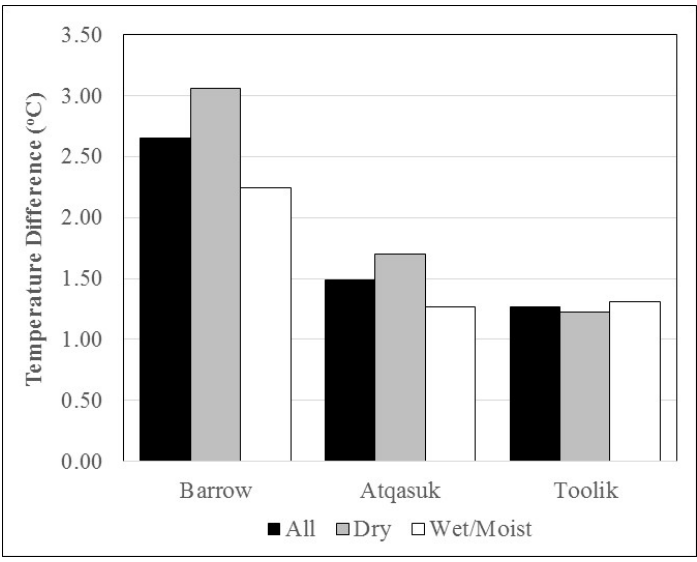
Figure 9. Mean difference between Open Top Chamber (OTC) and control plot surface temperatures (OTC—control).